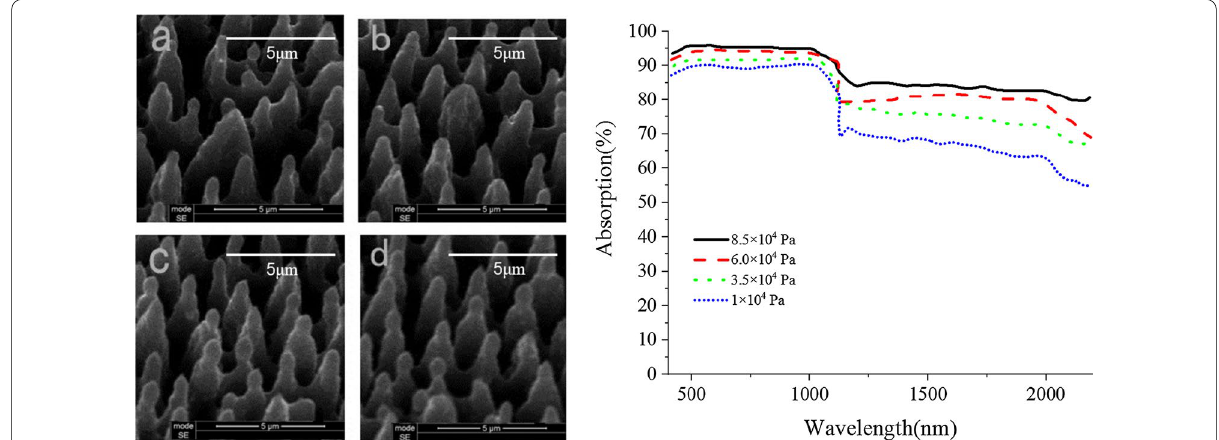
Fig. 9 The surface morphology and absorption spectra of the materials at different HF air pressure a 1 8.5 10 4 ×